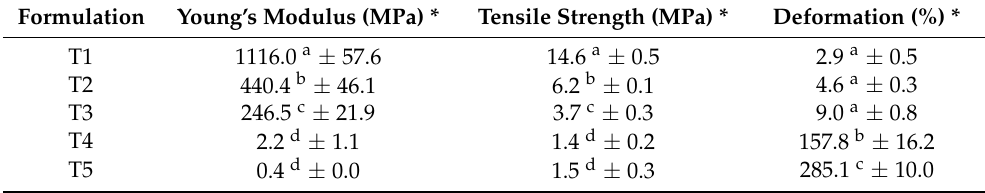
Table 1. Mechanical properties of cassava starch/gelatin films: T1 (gelatin/cassava starch 0/100; T2 gelatin/cassava starch 25/75; T3 gelatin/cassava starch 50/50; T4 gelatin/cassava starch 75/25; T5 gelatin/cassava starch